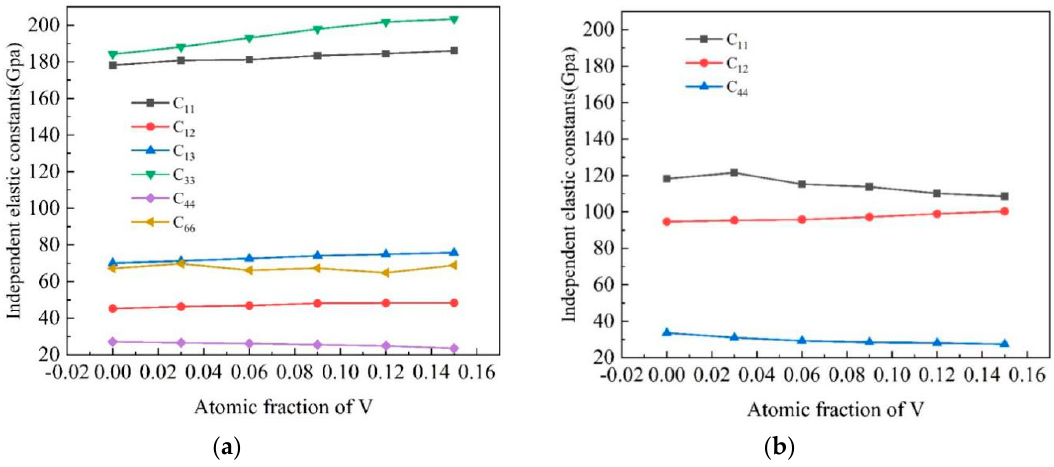
Figure 5. ( a ) E ff ect of V atomic fraction on the independent elastic constants of HCP-structured Zr-Ti–V